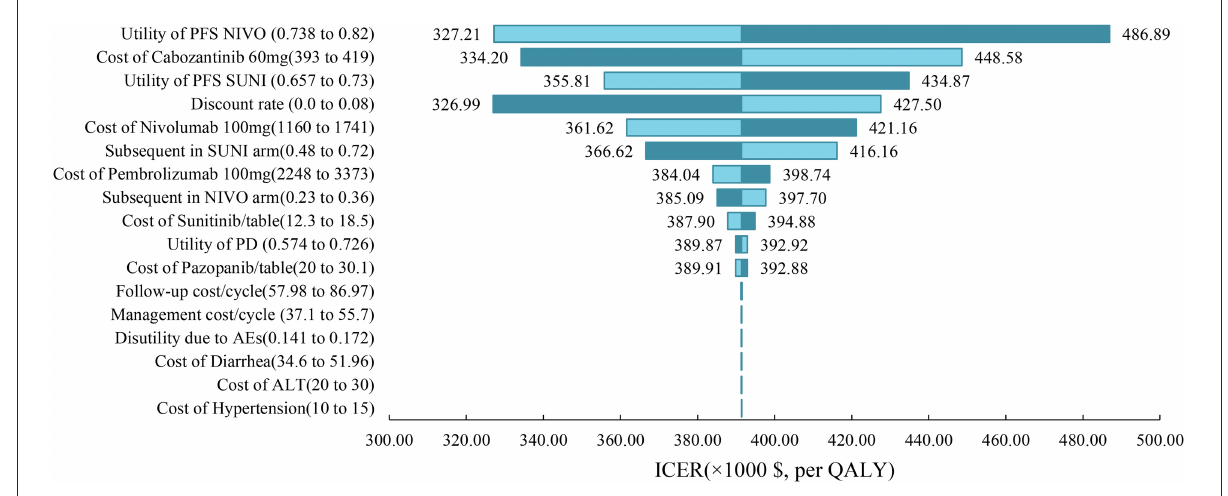
FIGURE3 Tornado diagrams showing the effect of lower and upper values of each parameter on the ICERs of the NI + CA vs. sunitinib strategy.